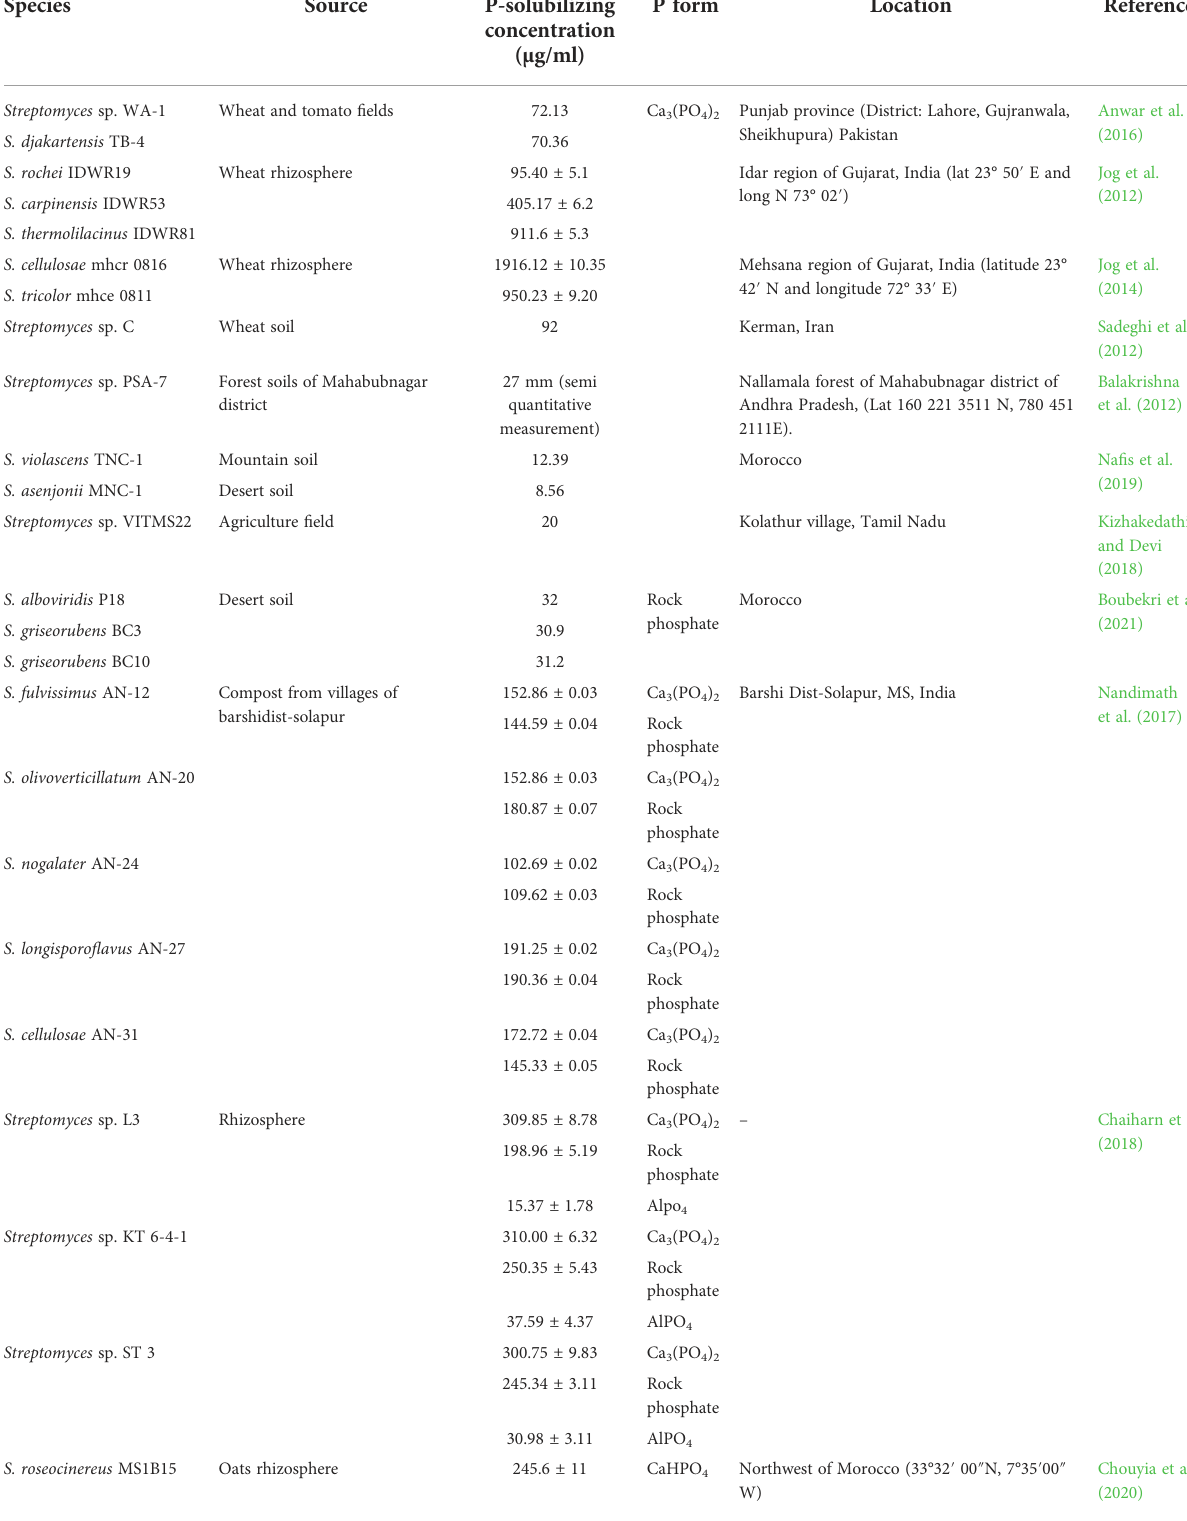
TABLE 1 Studies on the phosphate-solubilizing Streptomyces species within past 10